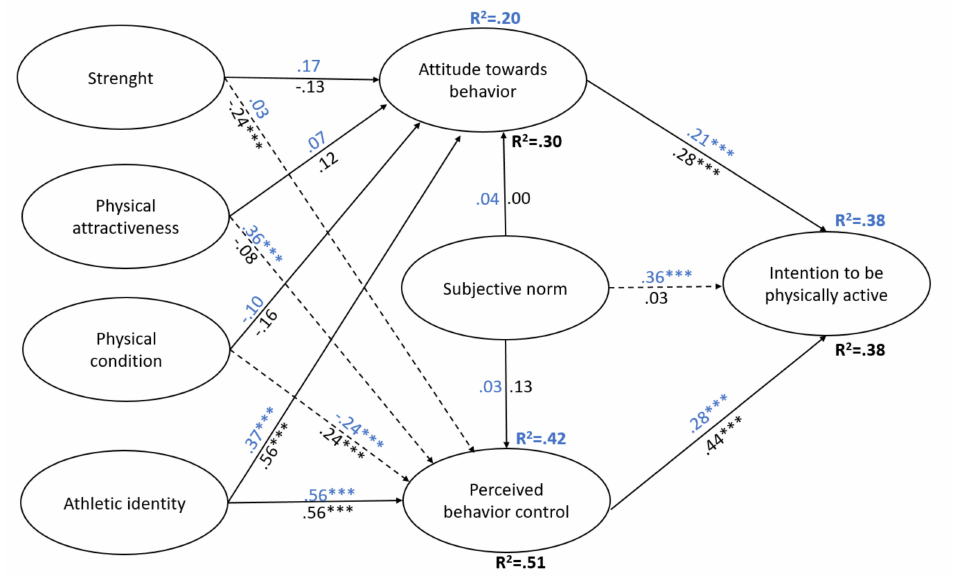
Figure 2. Model of intention to be physically active after graduating with male vs. female sample. Note: male coe ffi cients are below the line in blue, and female coe ffi cients are under the line in black. Discontinuous lines refer to significant di ff erences between male / female path coe ffi